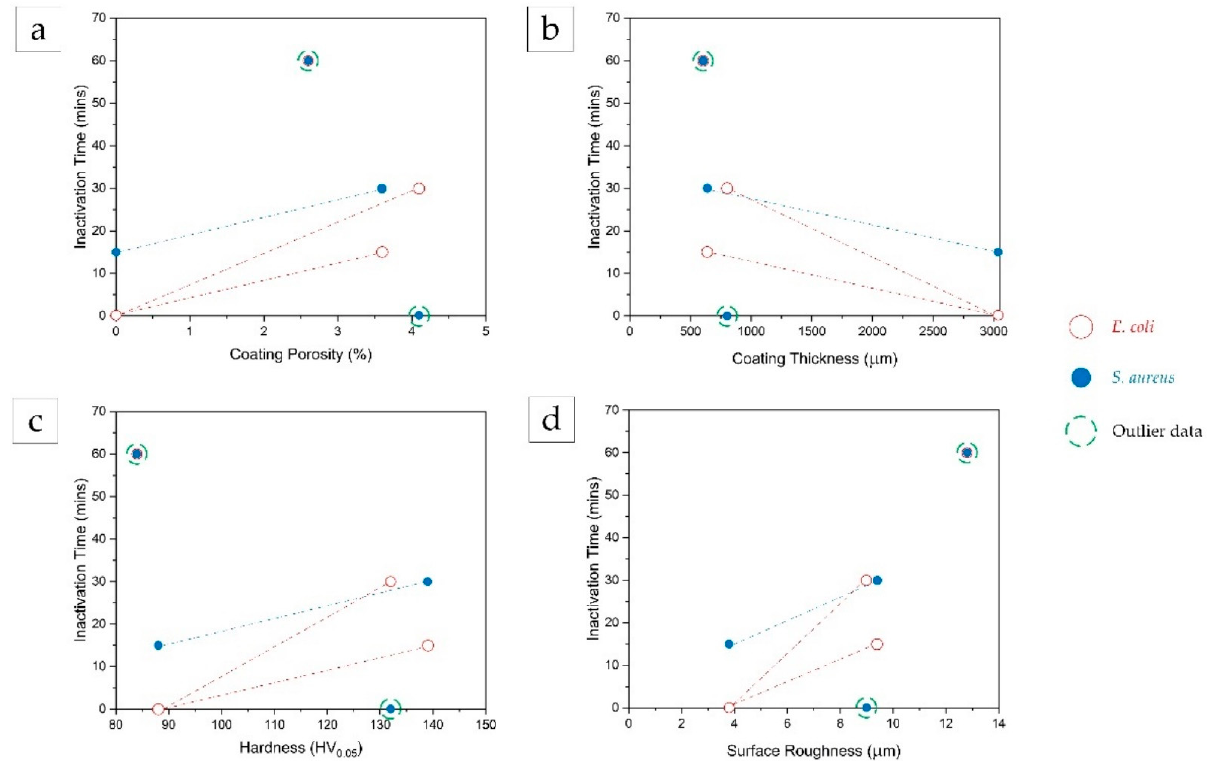
Figure 12. Effect of coating properties, ( a ) porosity, ( b ) thickness, ( c ) hardness, and ( d ) surface roughness, on the inactivation times for E. coli and S. aureus bacteria.